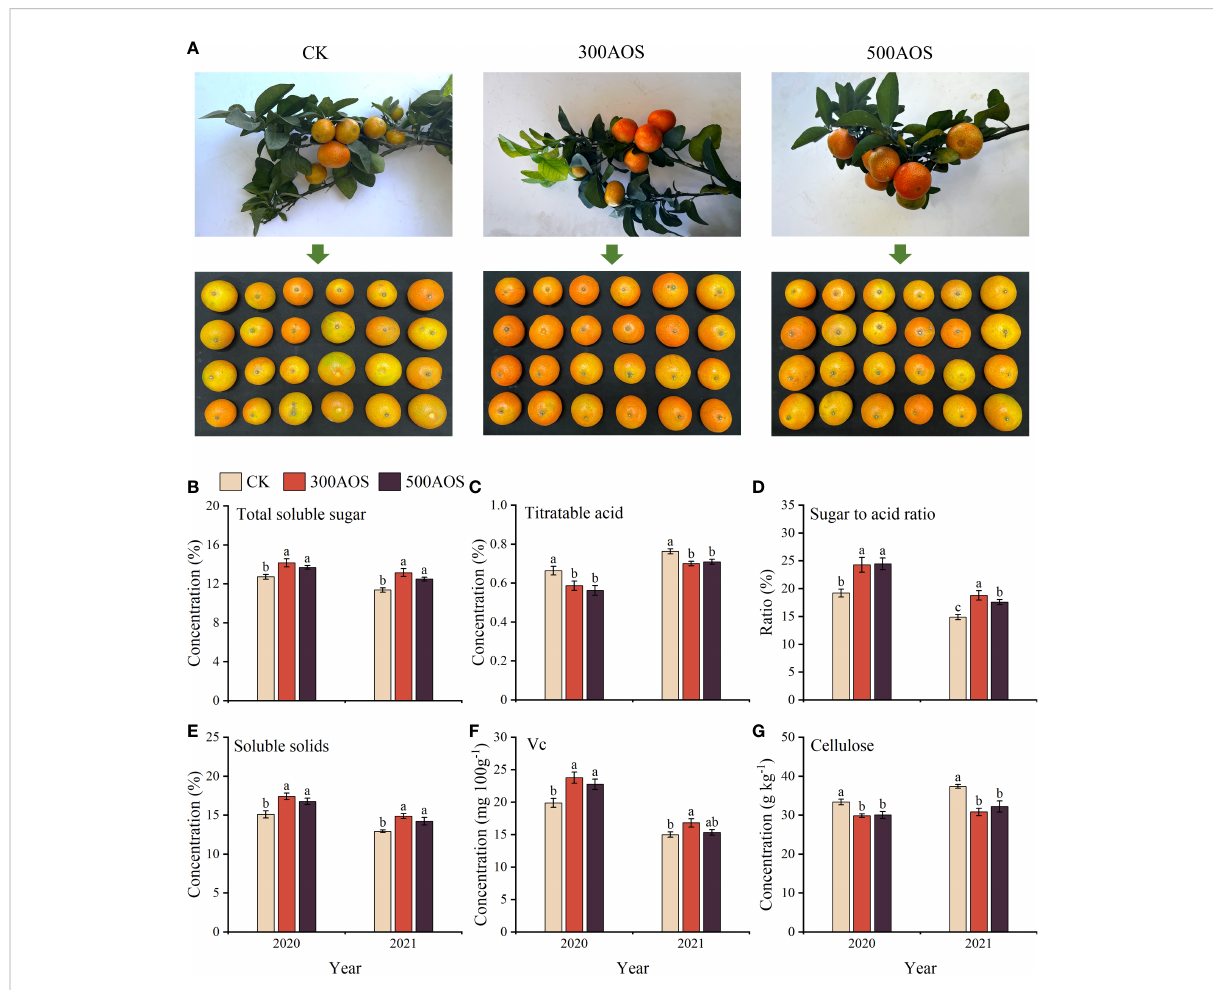
FIGURE 2 Effect of AOS on citrus fruit quality. Citrus fruit phenogram (A) , total soluble sugar content (B) , titratable acid content (C) , sugar to acid ratio (D) , soluble solids content (E) , Vc content (F) and cellulose content (G) . Different lowercase letters indicate signi fi cant differences among the treatments, based on the Duncan test ( p < 0.05, n =